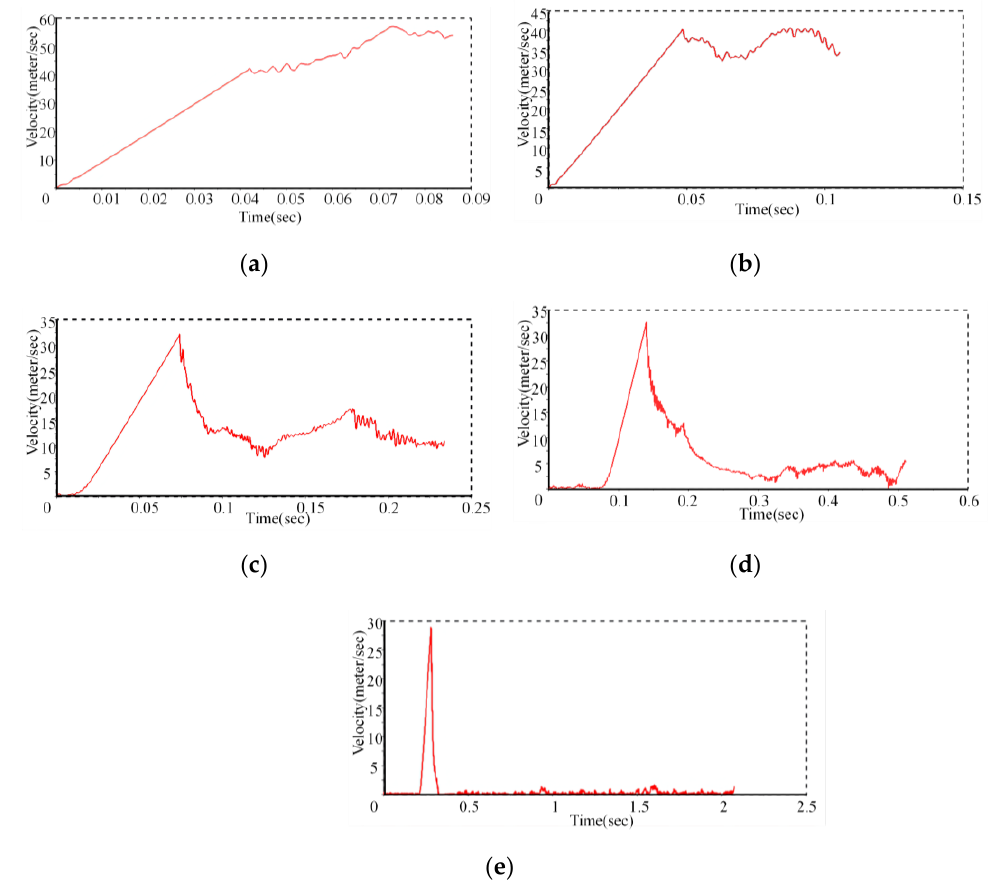
Figure 6. Comparison of the speed of different cup numbers of pipe cleaners through bends: ( a ) number of cups is 2, ( b ) number of cups is 3, ( c ) number of cups is 4, ( d ) number of cups is 6, ( e ) and number of cups is 8.